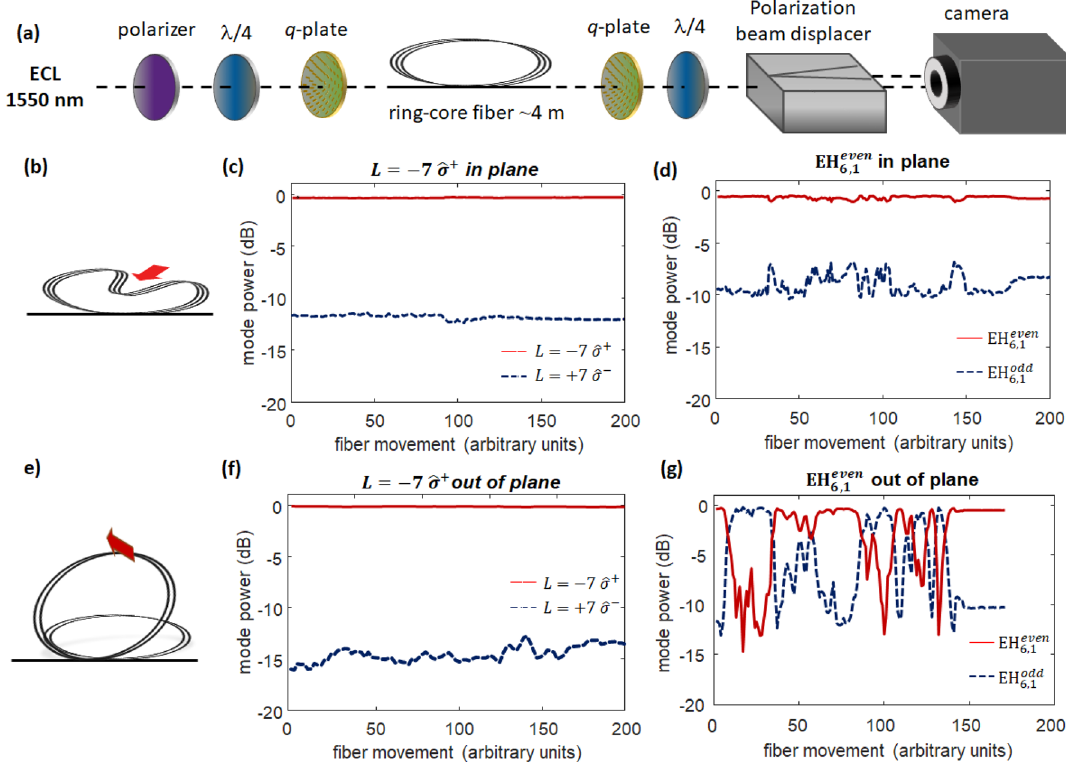
Figure 5: (a) Experimental setup used for studying the mixing ratio of two degenerate orbital angular momentum (OAM) or vector modes. For the OAM basis,thequarter-waveplate ( λ /4) is rotatedto an anglesuch thatthe fast axisis 45 ° with respectto the axisof polarizerto generate circularly polarized light, which is converted to OAM modes by the q -plate. In contrast, for the vector basis, the fast axis of the quarter-wave plateisalignedwiththeaxisofthepolarizer,suchthatlinearlypolarizedlightcanbeprojectedontocorrespondingvectormodes;Areciprocal setupatthe fi beroutputconvertsthemodesbacktoGaussianbeams,with thepowerineachpolarizationbinbeingproportionaltothepower of the individual degenerate (OAM or vector) modes at the fi ber output. For the vector mode measurement, the output quarter-wave plate is removed. When measuring OAM mode stability, the input was a ∼ 15-dB pure L (cid:1) − 7 (cid:6) σ + mode, whereas, during the vector mode stability measurements, the input was a ∼ 10-dB pure EH even mode. (b) Schematic of fi ber loops being bent in-plane to varying degrees, during the 6 , 1 measurement. Part of the fi ber loops (radius ∼ 12 cm) are gradually bent into radius ∼ 4 cm, and then return back to the original; (c) Plot of relative power in the two degenerateOAM modes ( L (cid:1) ∓ 7 (cid:6) σ ± ) underthe application of perturbations as shown in (b); (d) Corresponding plot of relativepowerinthetwodegenerateEH 6 , 1 modesforin-planeperturbations;(e)Schematicof fi berpartly(2outof4 fi berloops)beingliftedout ofplanetodifferentheightsduringmeasurements.Theplaneoflifted fi berismovedtotheplaneperpendiculartotheoriginalandthenmoved back; (f) Plot of relative power in the two degenerate OAM modes ( L (cid:1) ∓ 7 (cid:6) σ ± ) as the fi ber is moved out of plane, as shown in (e); (g) Corresponding plot of relative power in the two degenerate EH 61 modes for out-of-plane perturbations. OAM modes remain stable to bend as well as 3D perturbations, while the vector modes are completely mixed by 3D path redirections of the fi